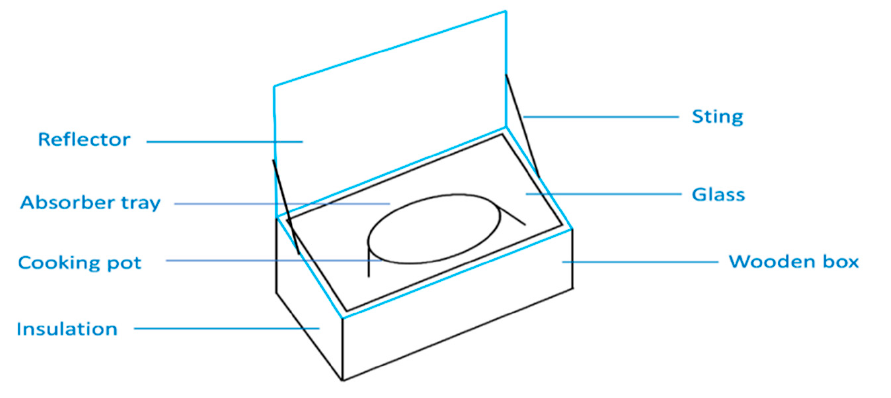
Figure 2. Schematic of box-type solar cooker .